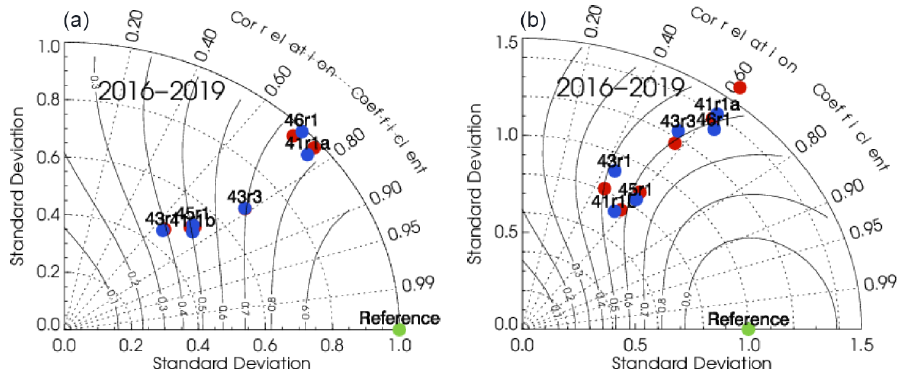
Figure 6. Taylor plot combining Pearson’s correlation coefficients (azimuth) and standard deviation normalized towards ceilometer obser- vations (radius) from daily average β ∗ (z) profiles of IFS-AER versus ceilometers for 2016–2019. (a) Median of all data; (b) mean over 221 Saharan dust days as defined in Sect. 3.4.1. Red dots denote ASM; blue dots denote the corresponding CTR. Note the different x and y